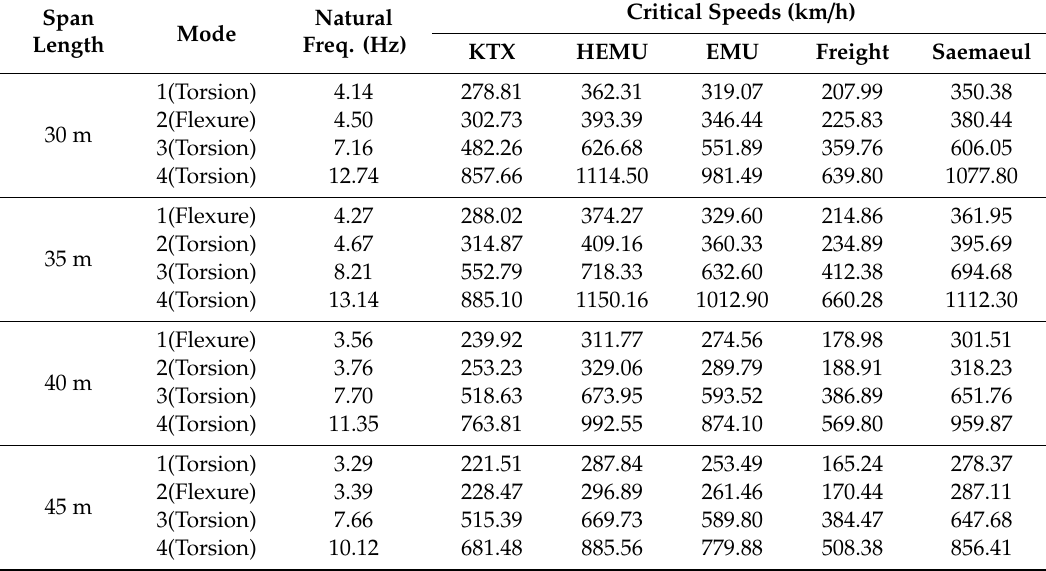
Table 5. Analytically obtained natural frequencies and critical speeds per train